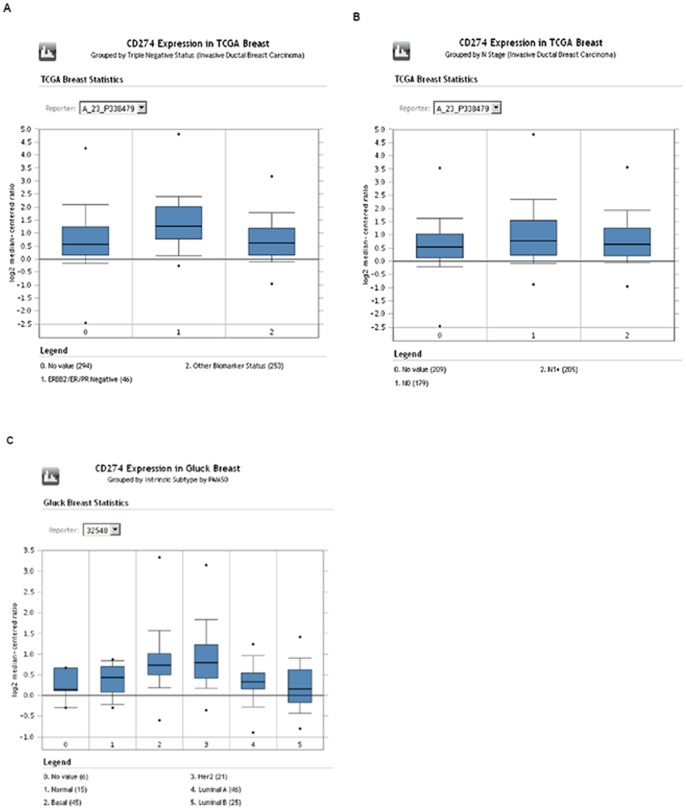
Oncomine box plot RNA expression data for PD-L1 (CD274) shown within the TCGA (Fig 5A. TNBC and Fig 5B. nodal status) and Fig 5C. Gluck datasets (PAM50 data).